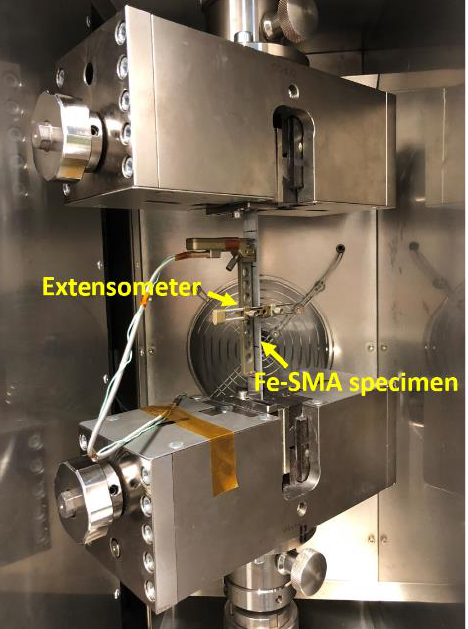
Figure 4. Inner part of the climate chamber on a Z020 Zwick machine: a FeMnSi-SMA specimen was fixed between two clamps, and the clip-on Mini MFA 2 extensometer was installed on the specimen.